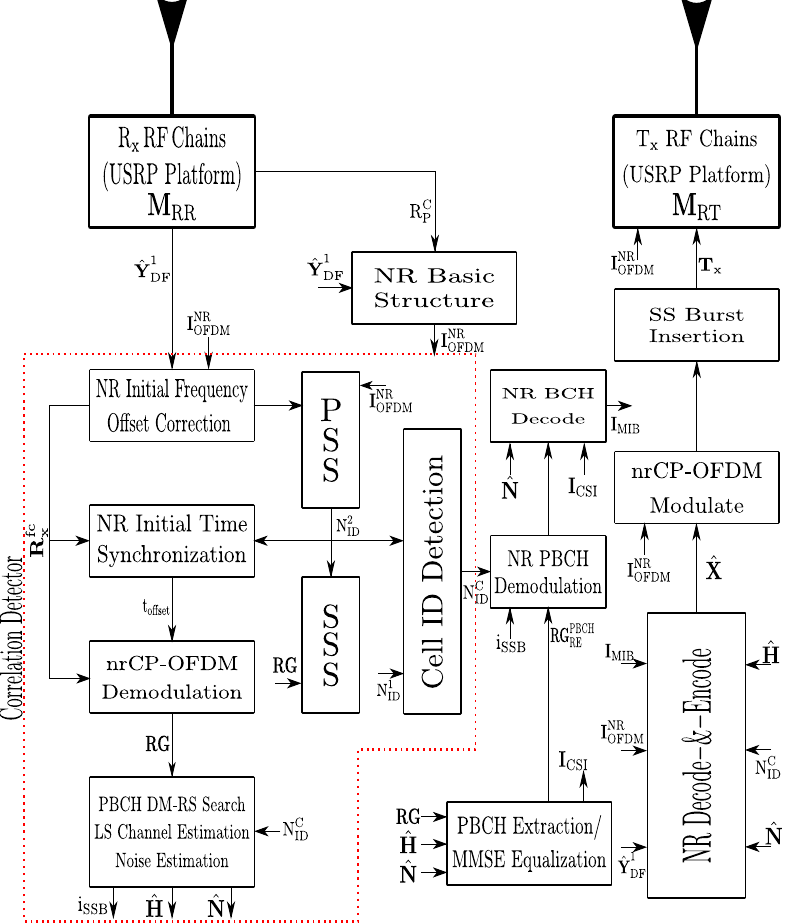
Figure 6. Proposed flowchart to hardware interface of 5G decode-and-forward relay